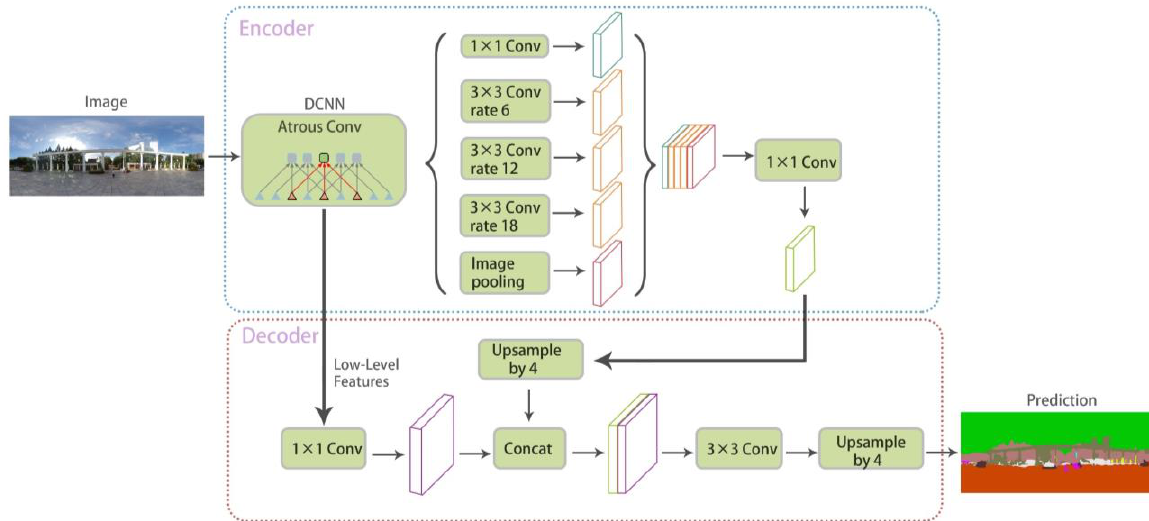
Figure 4. DeepLab V3 + model structure diagram [36].